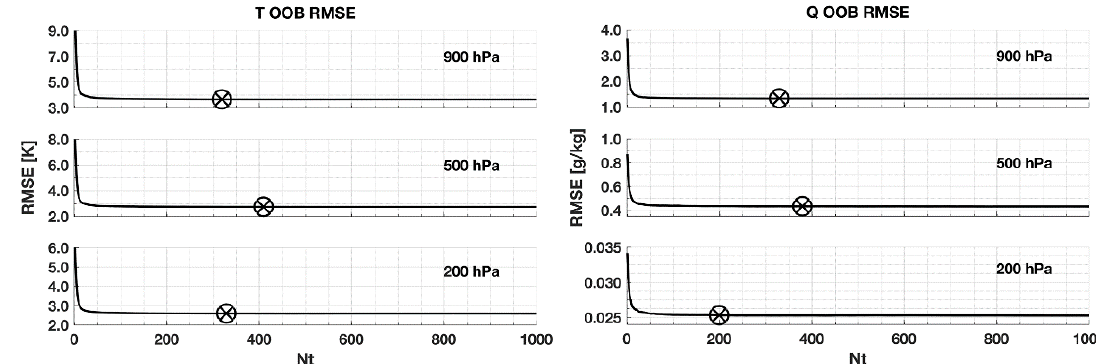
Figure 5. Nt parameter analysis for T ( left ) and Q ( right ) at three representative levels (top to bottom: 900, 500, and 200 hPa). The cross-circle markers indicate the selected values of the Nt parameter.